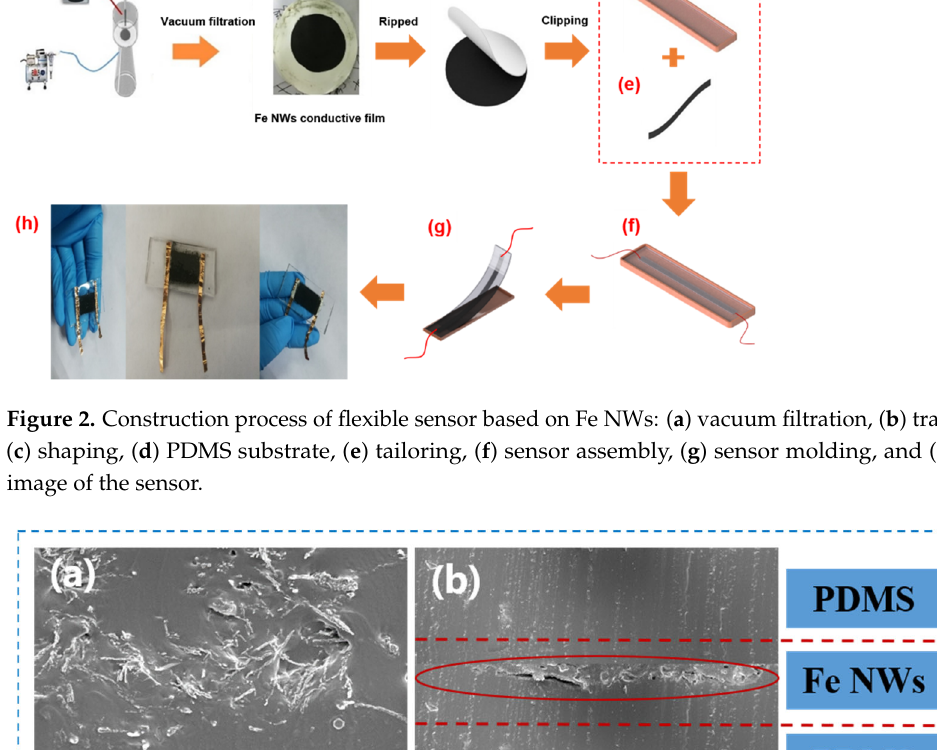
Figure 2. Construction process of flexible sensor based on Fe NWs: ( a ) vacuum filtration, ( b ) trans ‐ fer, ( c ) shaping, ( d ) PDMS substrate, ( e ) tailoring, ( f ) sensor assembly, ( g ) sensor molding, and ( h ) an image of the sensor.